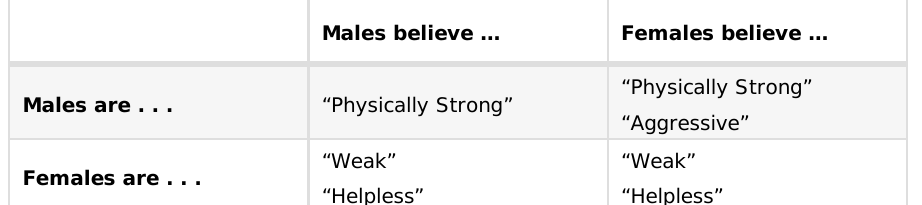
Stereotypical beliefs of males and females in Newbery award-winning novels regarding both males and females. Ex. “Males believe males are physically strong.” Males believe … Females believe … Males are . . . “Physically Strong” Females are . . .